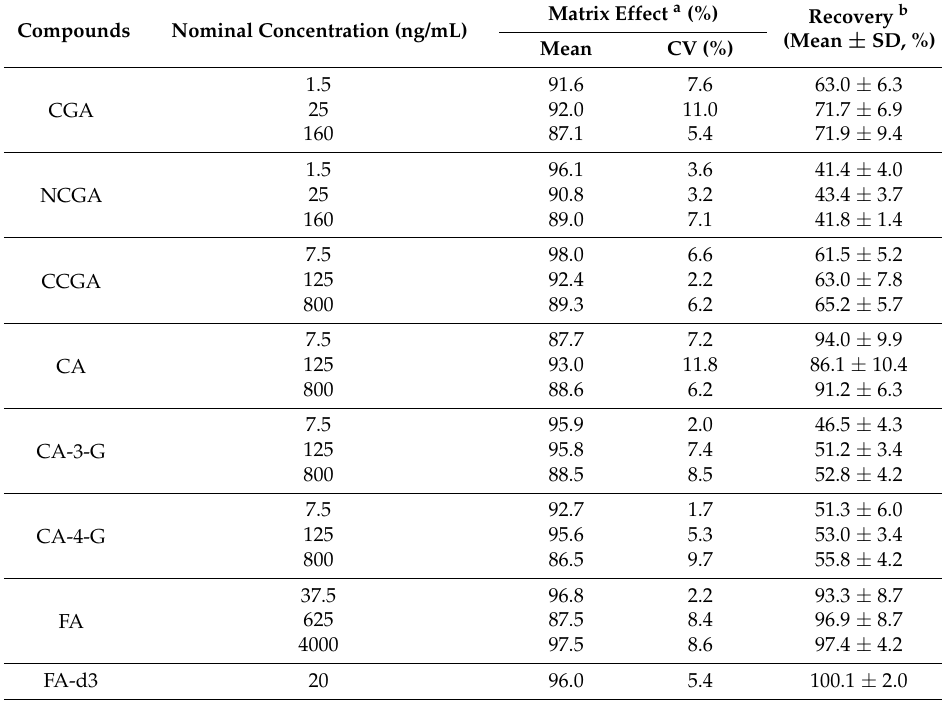
Table 2. Matrix effects and recoveries of CGA, NCGA, CCGA, CA, CA-3-G, CA-4-G, FA, and FA-d 3 (IS) using six different rat plasma ( n =